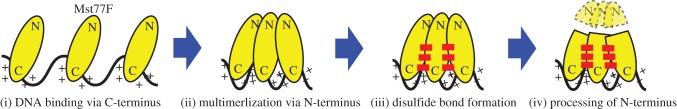
Model of sperm chromatin compaction and stabilization by Mst77F. (i) Mst77F (yellow ovals) first binds DNA through its C-terminus as proposed by Kost et al. [29]. (ii) DNA-bound Mst77F proteins multimerize through N-terminus interactions [29]. (iii) Mst77F intermolecular interactions are stabilized by disulfide bonds (red rectangles) connecting cysteine residues. (iv) Mst77F N-termini are finally removed by proteolysis, leaving only Mst77F-S on sperm chromatin.